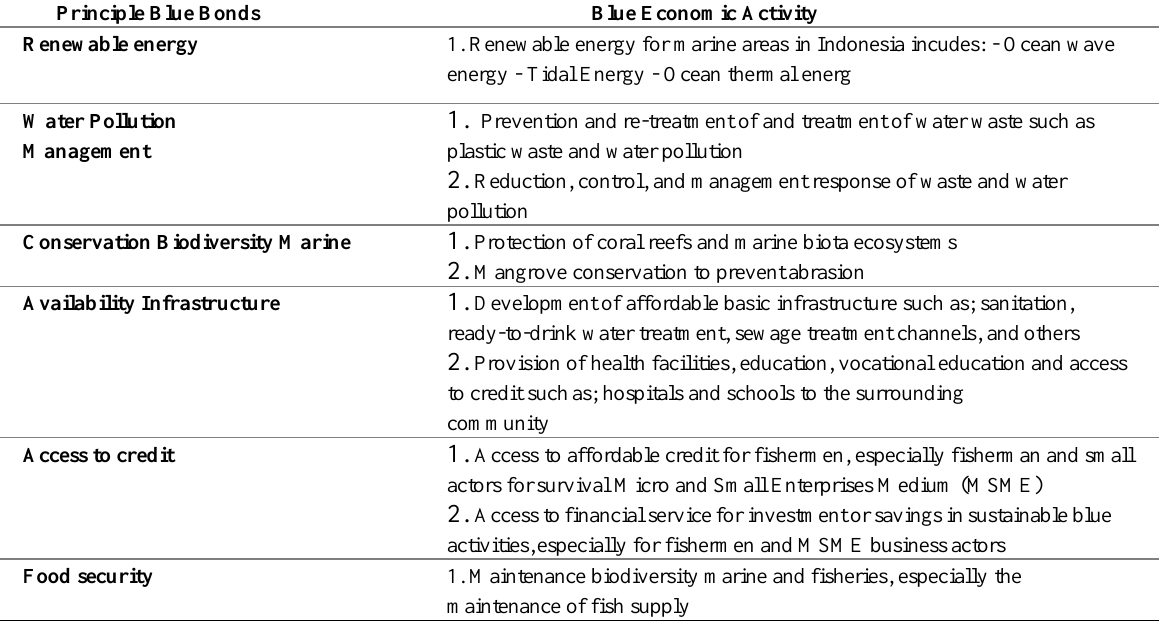
Table 1: Publishing Purpose Blue Bonds in